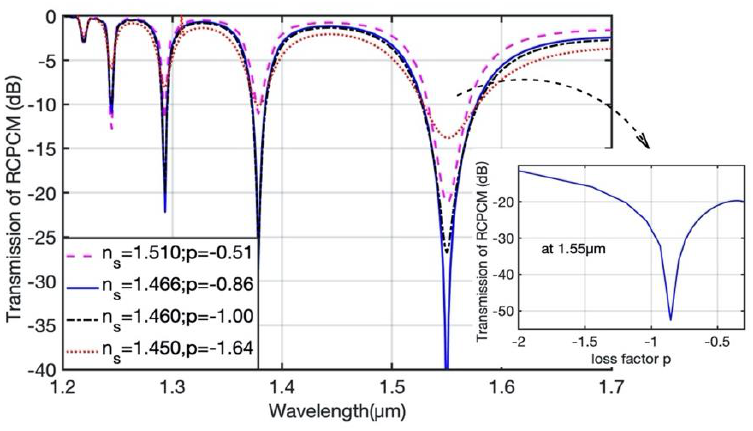
Figure 4. Transmission of the RCPCM with different-RI coatings.